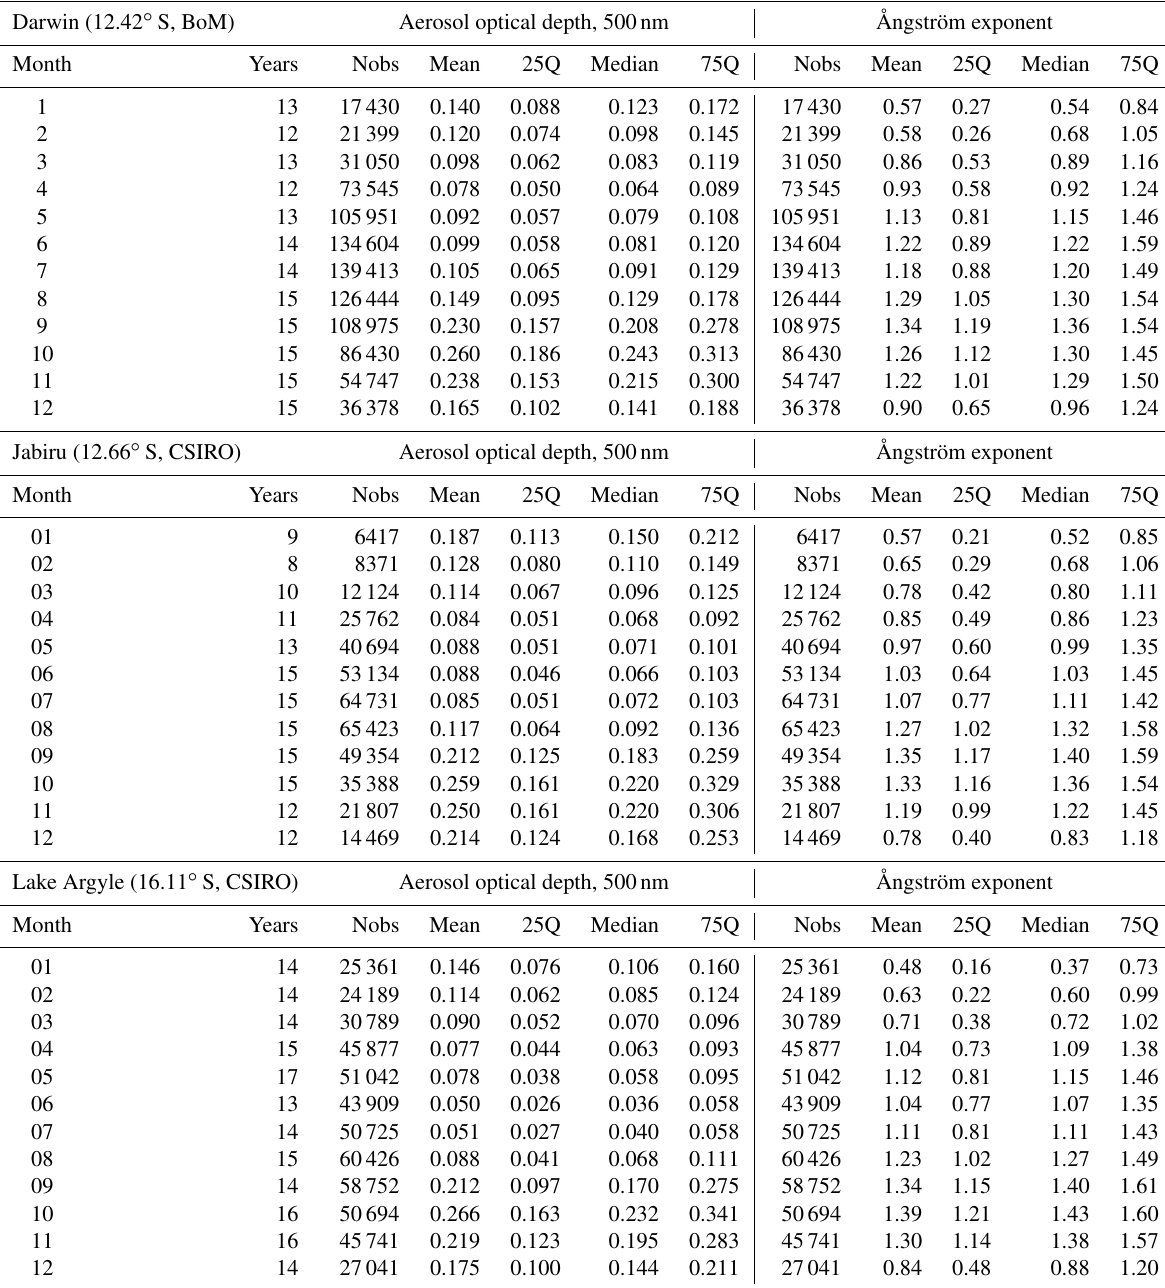
Table A1. Monthly climatology of 500nm aerosol optical depth and Ångström exponent at all 22 stations, listed in order of decreasing latitude. The column labelled “Nobs” lists the number of instantaneous determinations of the measurand underlying the statistics. The columns labelled 25Q and 75Q list the break points at the first quartile (25%) and third quartile (75%) respectively. For the Bureau stations (denoted “BoM” in the header), the Ångström exponent before 2009 was calculated using the wavelength pair (500, 778nm). For 2009 and beyond, the wavelength pair (500, 868nm) was used (see text). For the CSIRO AeroSpan stations, denoted “CSIRO”, the wavelength pair (440, 870nm) was used